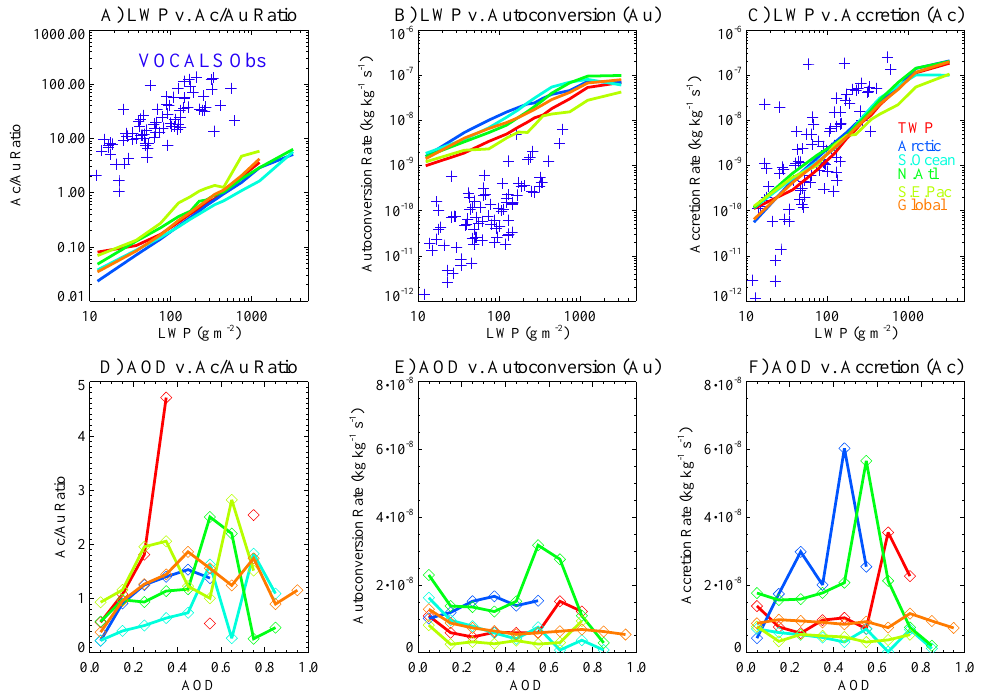
Figure 5. GCM Regional and global averages of vertically averaged (A) Accretion/Autoconversion ( A c /A u ) ratio v. LWP, (B) Autoconver- sion ( A u ) rate v. LWP and (C) Accretion ( A c ) rate v. LWP. Also shown are (D) A c /A u ratio, (E) A u and (F) A c v. AOD. Regions